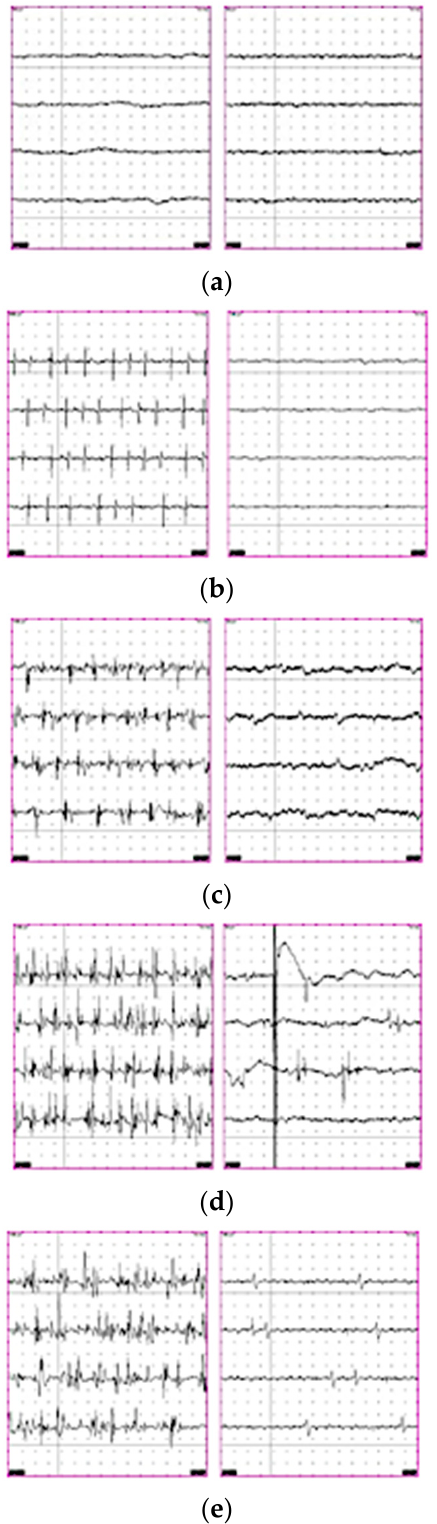
Figure 10. Progression of reinnervation in o. oris (left panels) and o. oculi (right panels). ( a ) Initial postoperative EMG: No activity. ( b ). O. oris with slight reinnervation. ( c ). O. oris with moderate activity. ( d ). O.oculi with slight reinnervation. ( e ). Cvasi-completely reinnervated o.oris and partially reinnervated o. oculi.